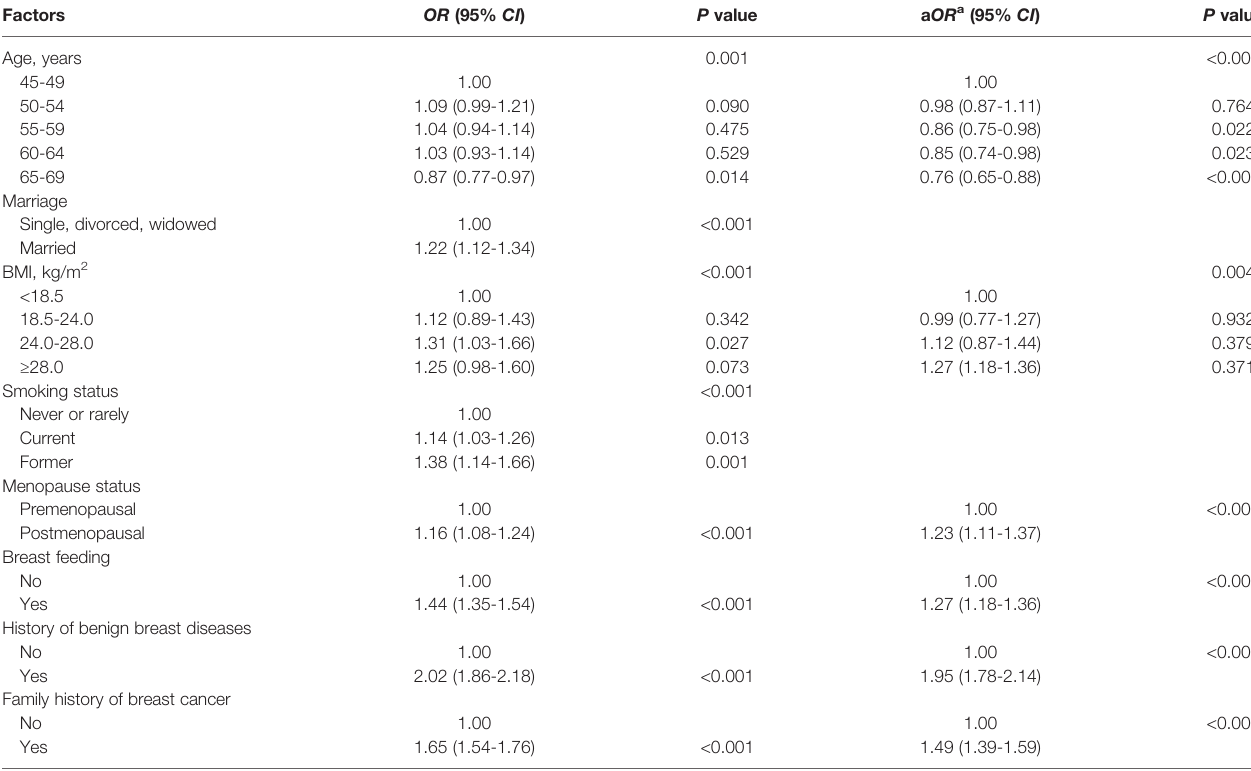
TABLE 2 | Factors associated with participation rate in breast cancer screening in Beijing.